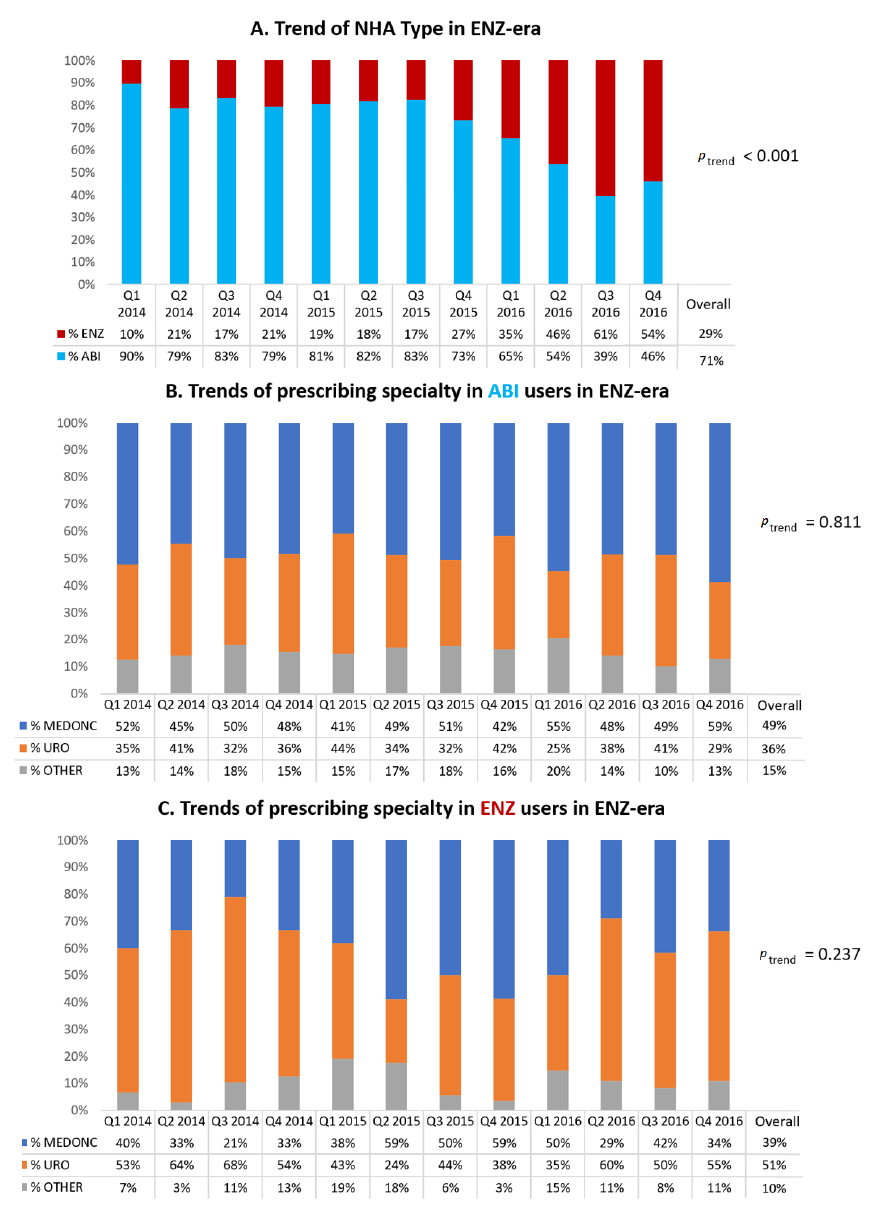
Figure 2. Temporal trends of novel hormonal agent (NHA) initiators in ENZ-era (2014–2016). ( A ) Trends of NHA type. ( B ) Trends of prescribing specialty in ABI users. ( C ) Trends of prescribing specialty in ENZ users.